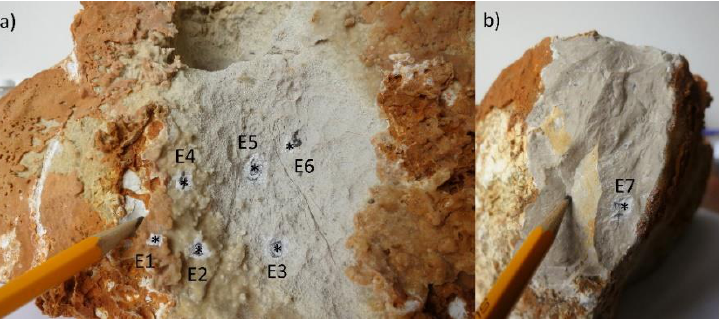
Figure 4. Rock sample with corrosion cups taken from SC Hall in Pisani Passage. Elemental composition samples were taken from seven different locations on the surface and marked with an asterisk, here six shown in ( a ) (E1–E6) and one in ( b ) (E7; the back of the rock sample).